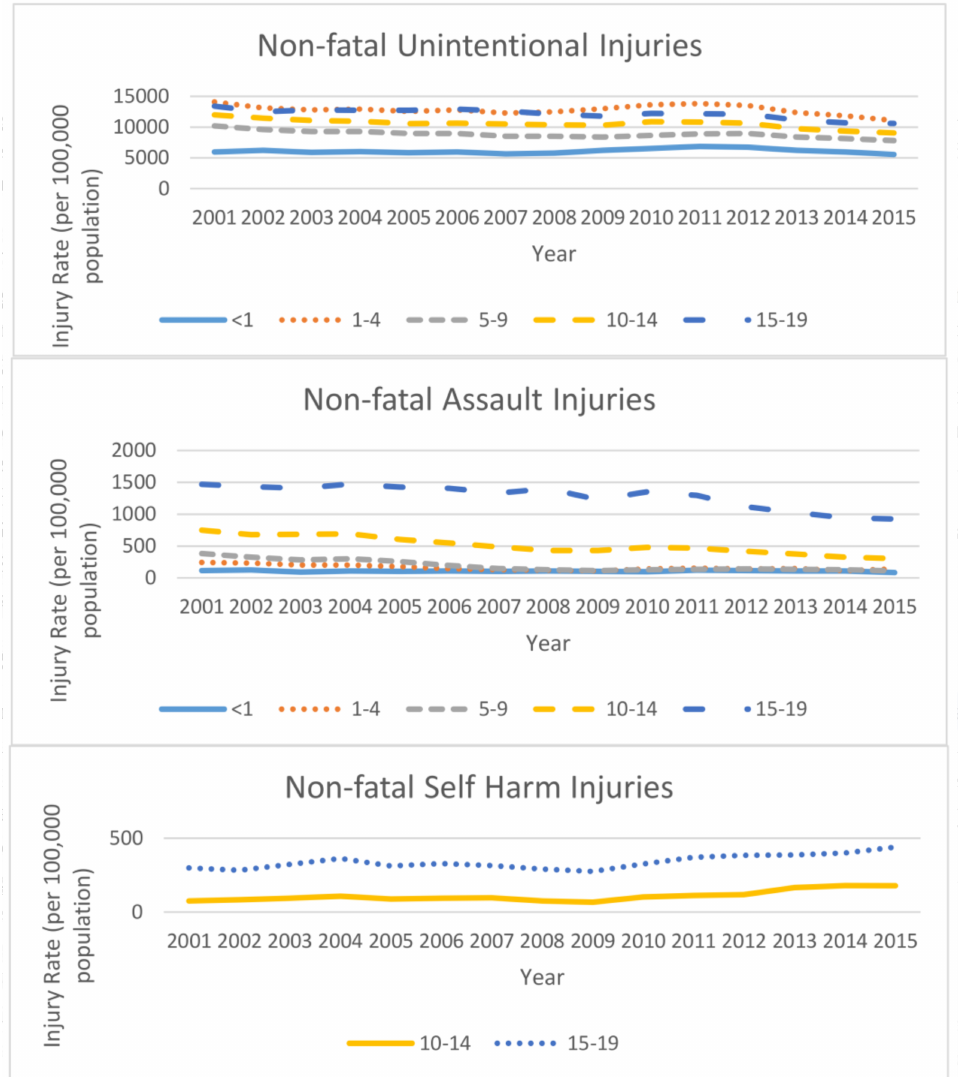
Figure 2. Non-fatal injury rates (per 100,000 population) among youth aged 0–19 years by intent, age group, and year, National Electronic Injury Surveillance System-All Injury Program, United States,